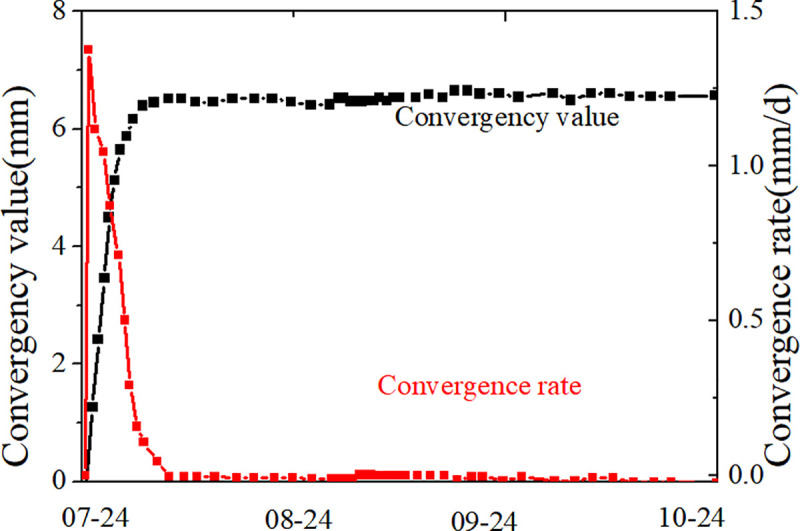
Curve of convergence and convergence rate of AB side of portal.